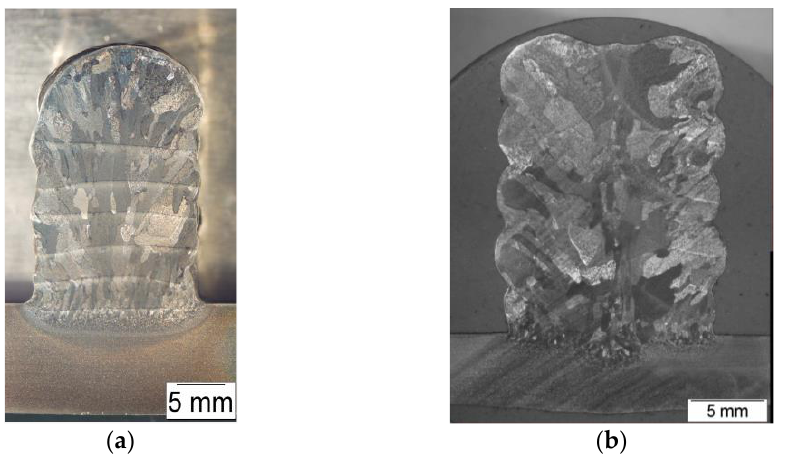
Figure 10. Cross section of walls: ( a ) single weld bead strategy wall, ( b ) three overlapped weld beads strategy wall.